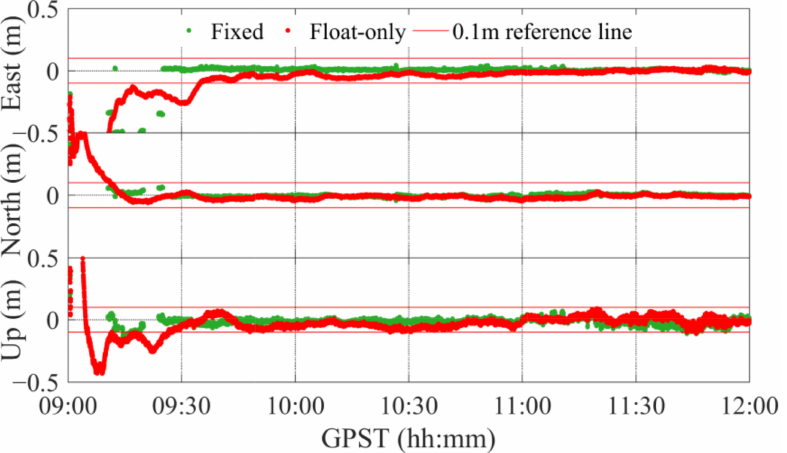
Figure 9. Fixed and float-only solutions for GPS L1 + Galileo E1 observations.